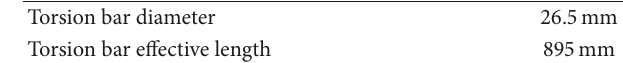
Table 2: Correction coefficients.